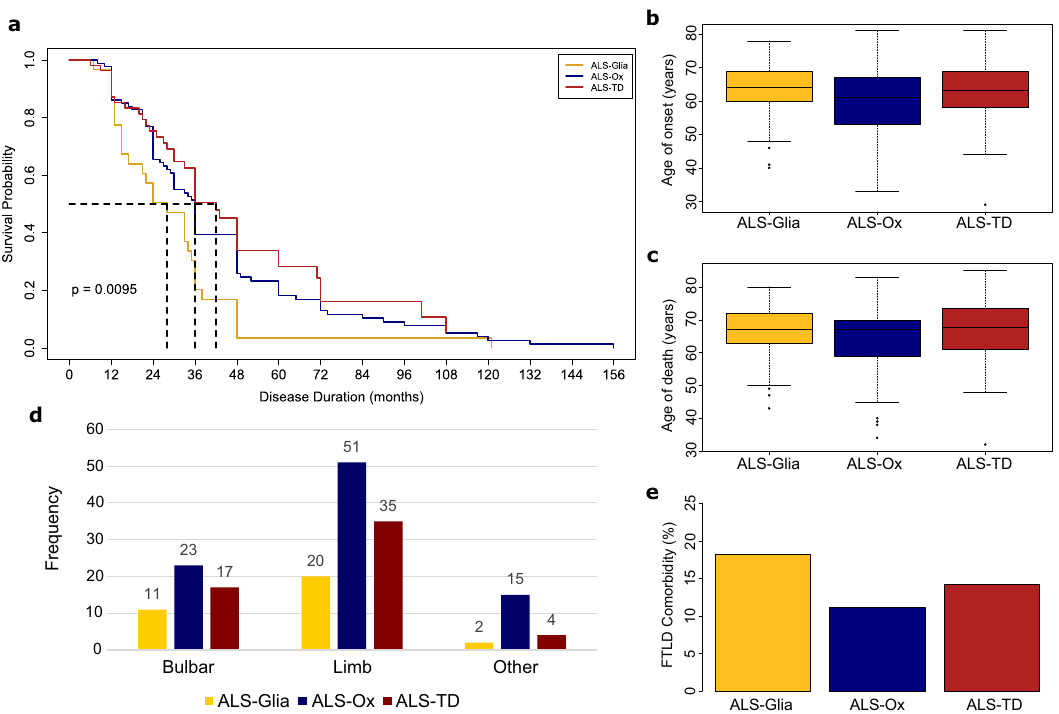
Fig. 5 | Assessmentof ALSpatient clinical parameters inthe context ofdisease subtypes. a Kaplan – Meier survival for the three identi fi ed ALS subtypes, with n =150patients.Patientswithoutanavailableageofonsetordiseasedurationwere excluded from this analysis. The ALS-Glia subtype is signi fi cantly associated with a shortersurvivalduration( p <0.01,log-ranktest).TheALS-Oxsubtypehadamedian survival duration of 36 months, while the ALS-TD group had the longest median survival (42 months). b Age of disease onset plotted as boxplots for the three ALS subtypes, with n =151 patients. No signi fi cant differences are observed in age of onsetbysubtype.Themedianisindicatedbythesolidblackline,and fi rstandthird quartiles are captured by the bounds of the box. Boxplot whiskers are de fi ned as the fi rst and third quartiles – /+ interquartile range times 1.5, respectively, and